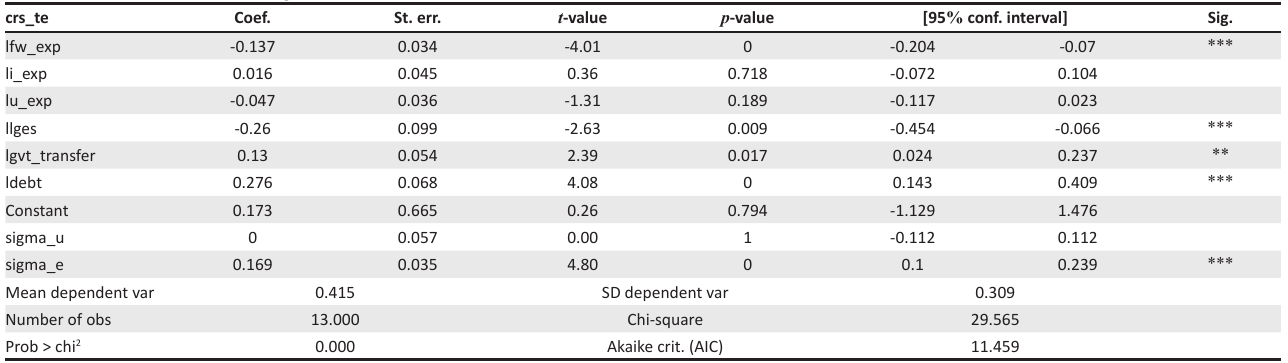
TABLE 1-A1: Random-effects tobit regression.